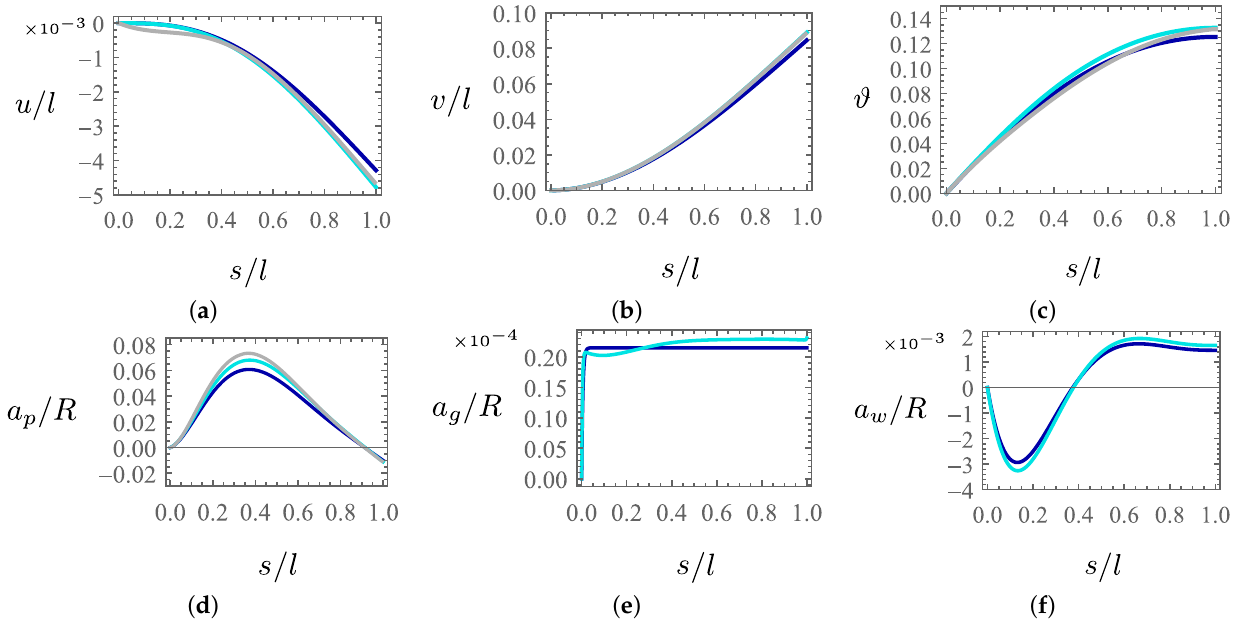
Figure 6. Response in the case of the uniformly distributed vertical load: ( a ) longitudinal displacement u / l ; ( b ) v / l ; ( c ) transversal displacement ϑ ( rad ) ; ( d ) amplitude of ovalization a p / R ; ( e ) amplitude of relative sliding a g / R ; ( f ) amplitude of warping a w / R . Blue lines: perturbation solution; light blue lines: finite difference method; gray lines: FEM.